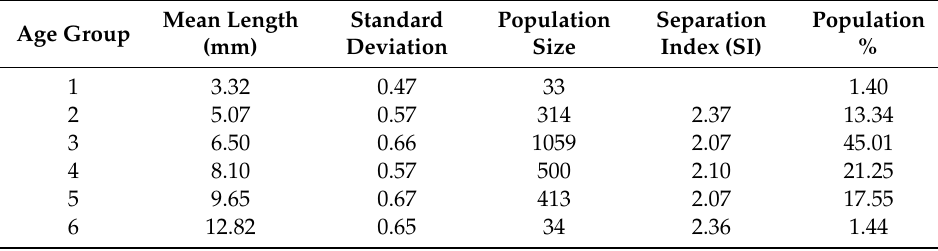
Figure 12. C. stellatus population cohorts identified with Bhattacharya’s method. Table 6. Population characteristics of the age groups identified for the entire C. stellatus population (mean length, standard deviation, population size, separation index, and population percentage at each age